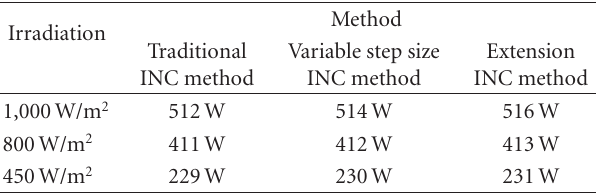
Table 4: Average value of steady-state power output under three types of irradiation using various MPPT